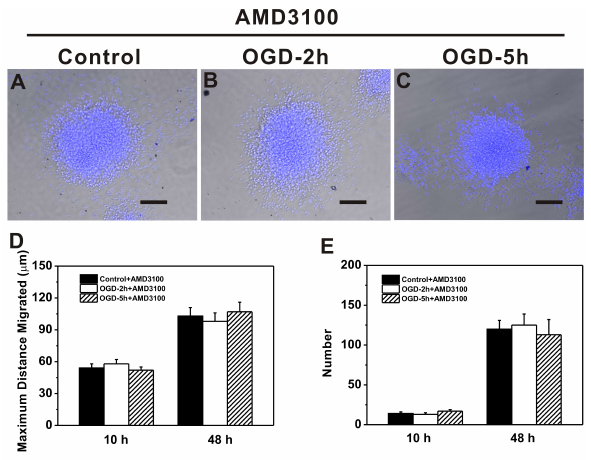
Figure 8. NSC migration in vivo during ischemic spinal cord injury. (A) Representative photos of NSC migration under ischemic spinal cord injury with or without AMD3100 treatment at day 2, 4 and 7 post-transplantation. Red: CM-DiI-labeled cells. Scale bar = 100 µm. (B) Histogram of the numbers of CM-DiI- labeled cells per 1 cm 2 in (A). Data were presented as mean ± S.E.M. *p < 0.05 vs